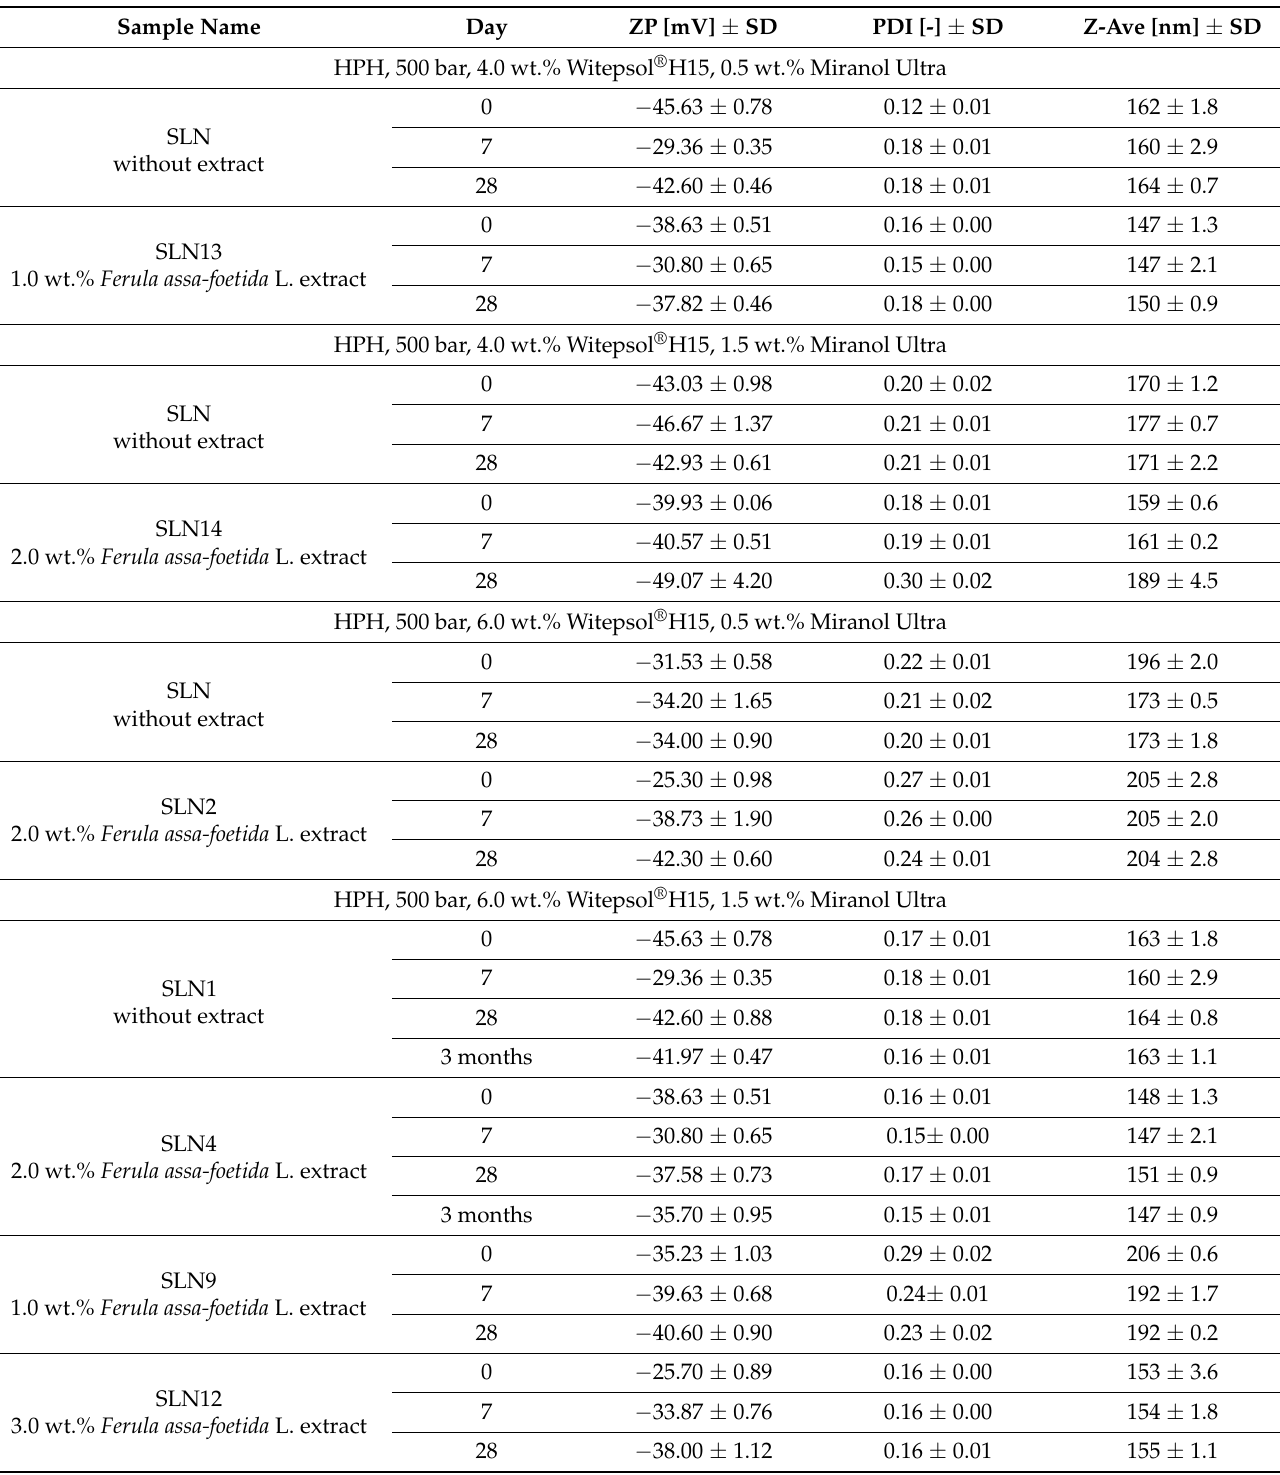
Table 5. Optimization of SLN synthesis parameters—comparison of zeta potential (ZP), polydisper- sity index (PDI), and average particle size (Z-Ave) of solid lipid nanoparticles (SLN) measured on the day of synthesis, and on the 7th, and 28th day after